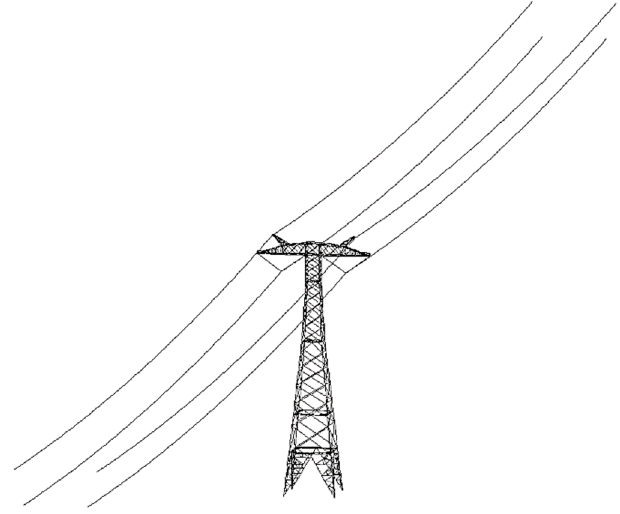
Figure 1. Details of transmission tower.